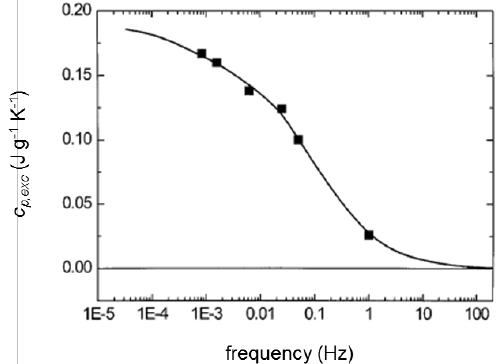
Figure 9. Excess specific heat capacity of PCL ( c p,exc ) after 2000 min of crystallization at 55 °C as a function of the modulation frequency. (Reprinted (adapted) with permission from [7]. Copyright (2000) Springer).